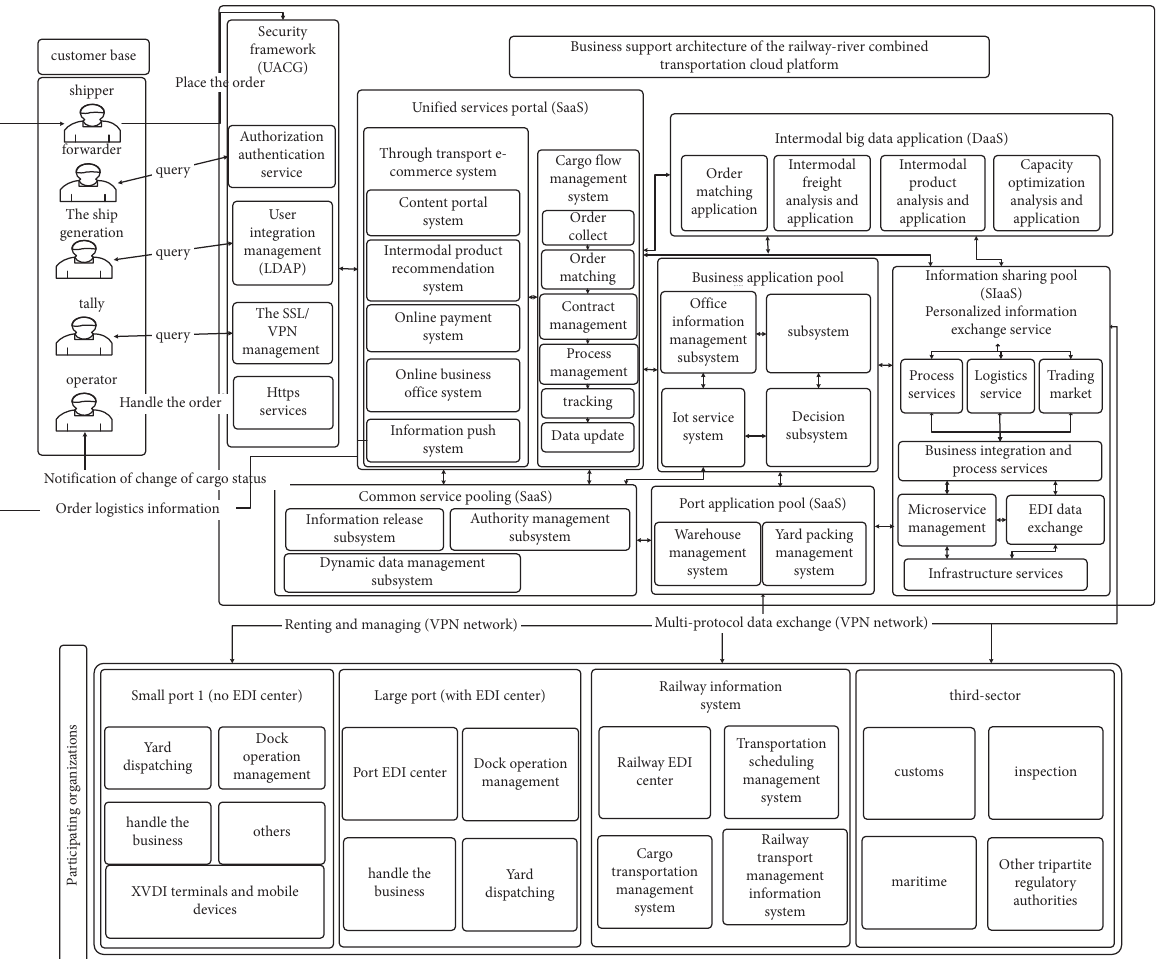
Figure 3: Business support